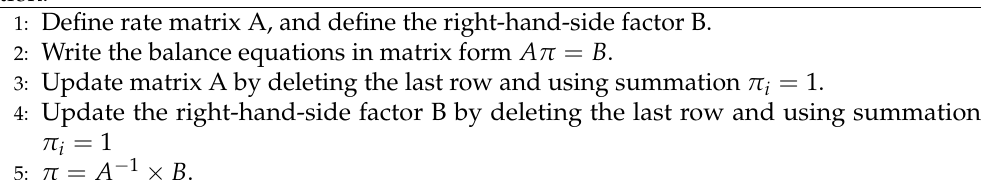
Algorithm 1 Pseudocode for solving balance equations in terms of a steady-state distribu-